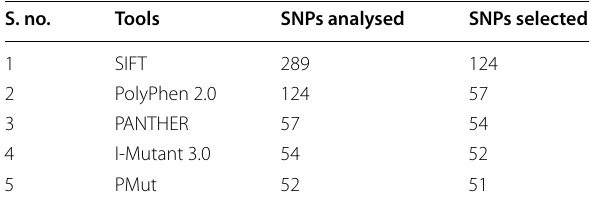
Table 3 Results of combined prediction using preliminary analysis